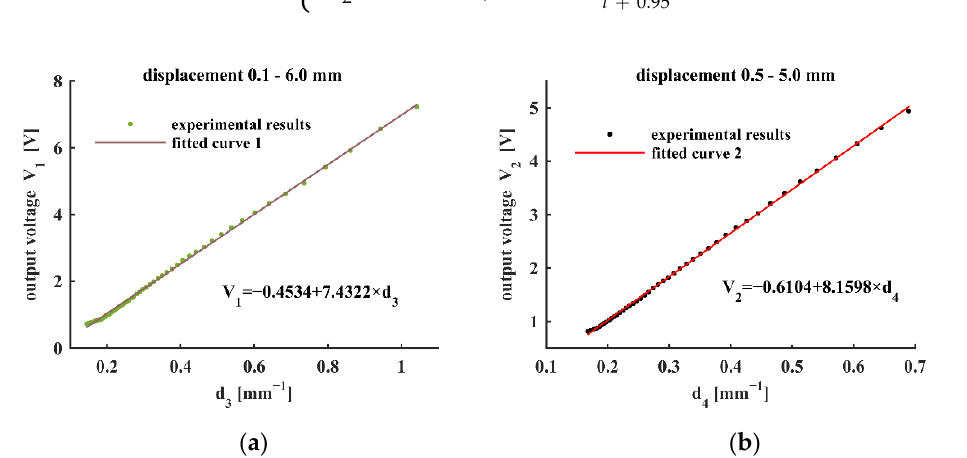
Figure 5. Linear fitting curves of magnetic flux density with d : d 3 = ( l + 0.86) − 1 and d 4 = ( l + 0.95) − 1 where l represents the displacement: ( a ) displacement range 0.1–6.0 mm; ( b ) displacement range 0.5–5.0 mm.